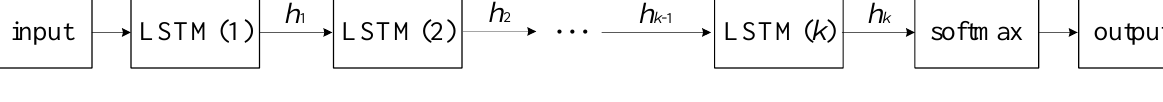
Figure 5. The structure of the stacked LSTM DNN Algorithm 2. Prediction procedure of LSTM